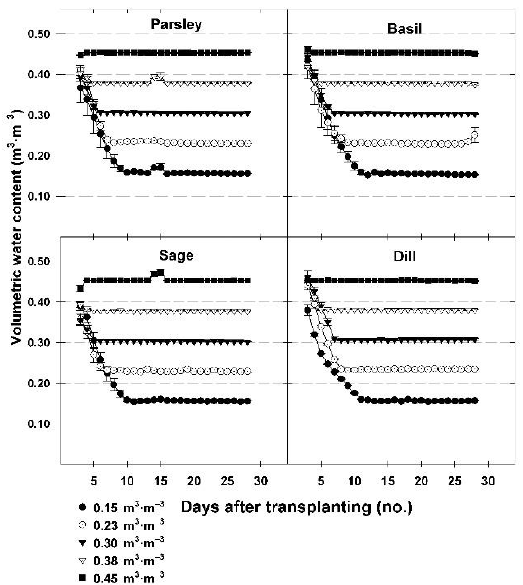
Figure 1. Substrate moisture for parsley and sage (Expt. 1) and basil and dill (Expt. 2) grown in 11.4 cm diameter containers filled with a soilless substrate comprising (by vol.) 75% sphagnum peat moss and 25% coarse perlite amended with 3.0 kg·m − 3 controlled-release fertilizer and maintained at 0.15, 0.23, 0.30, 0.38, or 0.45 m 3 · m − 3 substrate volumetric water content for four weeks.